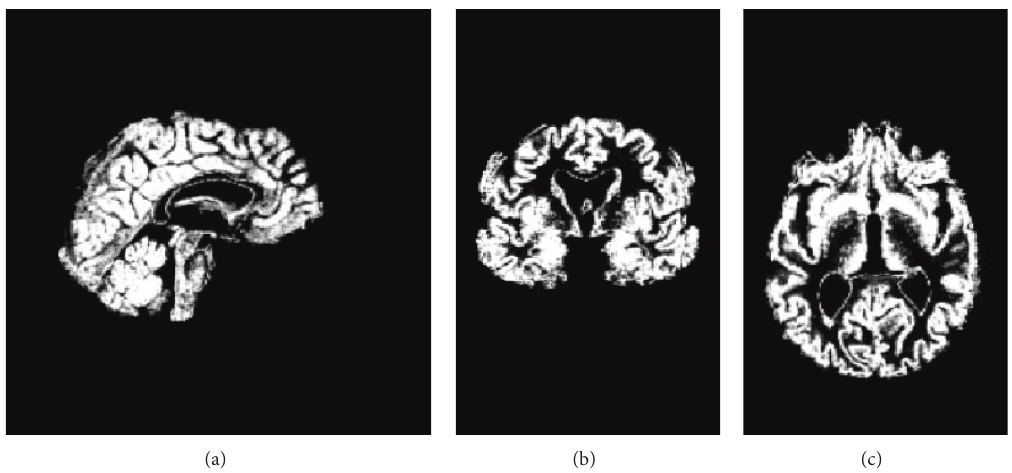
Figure 4: Segmentation results (gray matter) by the proposed method: (a) sagittal; (b) coronal; and (c)